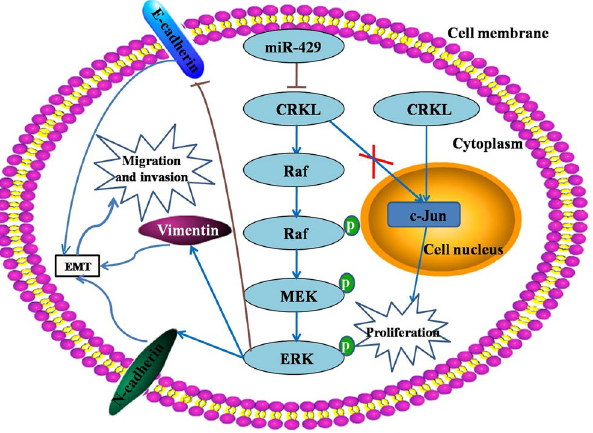
Figure 12. A schematic regulation mechanism of miR-429-CRKL axis on HCC cell malignant behaviours. miR-429 suppresses cell migration and invasion by targeting CRKL via Raf/MEK/ERK-EMT pathway; CRKL promotes tumor cell proliferation through upregulating c-Jun; miR-429 could not inhibit tumor cell proliferation through CRKL/c-Jun